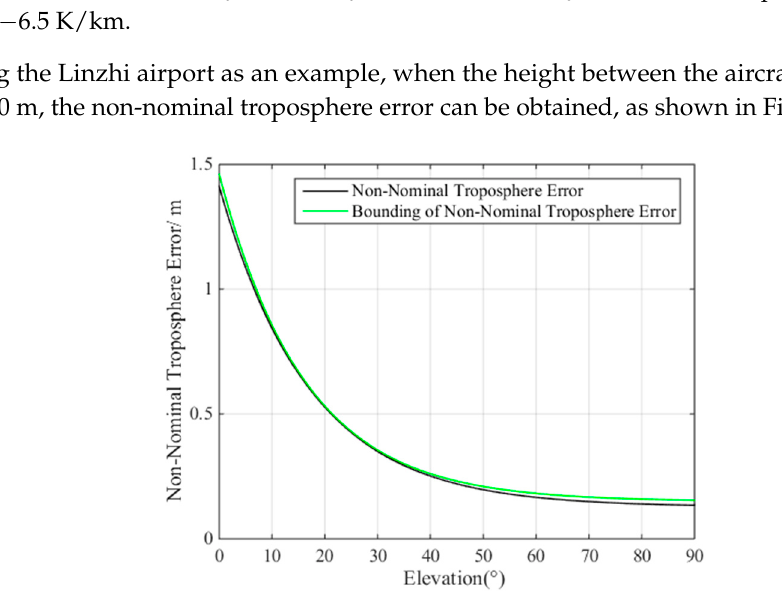
Figure 9. Relationship between the non-nominal troposphere error and satellite elevation.